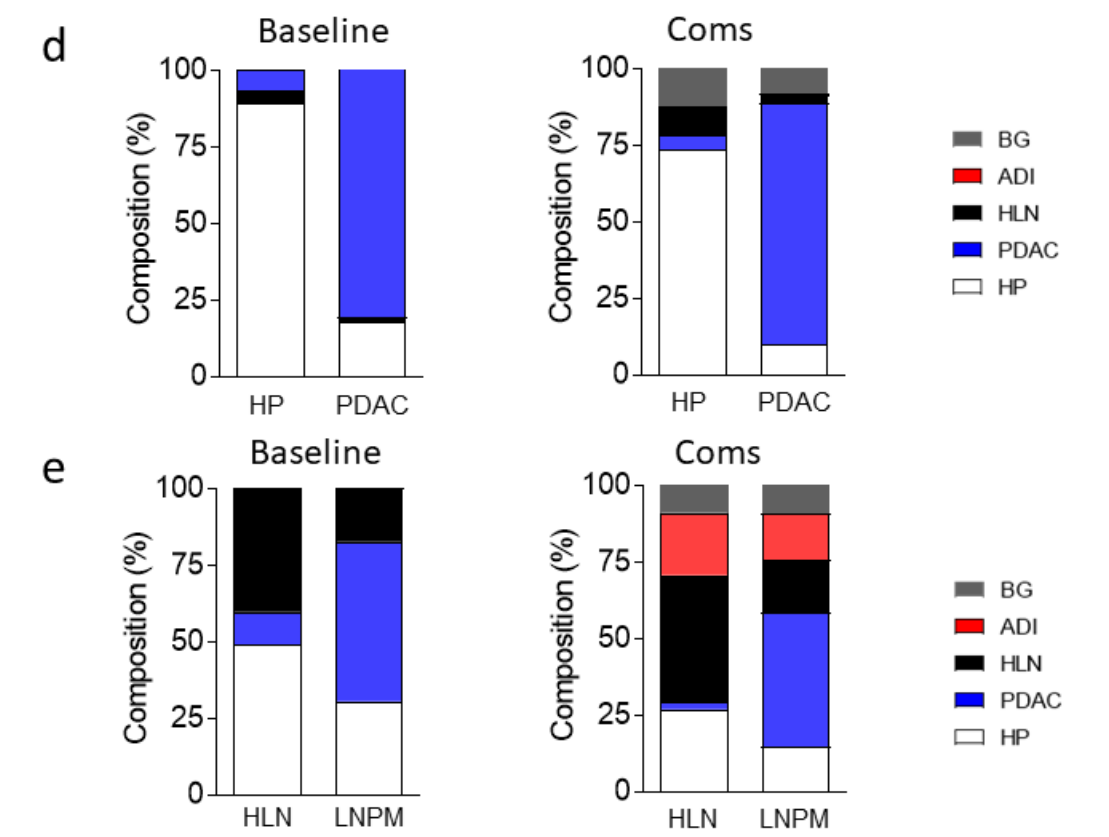
Figure 7. Communicator ‐ based clean ‐ up can be transferred to CNNs using a different input size. ( a ) Selection of the normalized 299 × 299 × 3 tissue patches based on the classification of the communicator CNNs using a 224 × 224 × 3 crop of the image tiles is illustrated (Spot: Scalebar = 300 μ m, Patch: Scalebar = 60 μ m). ( b ) Heatmap of the performance difference between the inceptionnetv3 trained on data with and without the data clean ‐ up via the communicators is shown. ( c ) Visualization of the classified validation data by the baseline or cleaned ‐ up inceptionv3 net. Healthy lymph node (HLN, yellow), healthy pancreas (HP, red), pancreatic ductal adenocarcinoma (PDAC, blue), background (BG, grey) and adipose tissue (ADI, cyan) classification is illustrated (scalebar = 2 mm). ( d ) Pooled classification, as determined using a baseline and cleaned inceptionv3 network from healthy pancreas (HP) ( n = 3) and pancreatic ductal adenocarcinoma (PDAC) images ( n = 15), is illustrated. ( e ) Average of classification, as determined using a baseline and cleaned inceptionv3 network of images showing healthy lymph nodes (HLN) ( n = 5) and lymph nodes with pancreatic ductal adenocarcinoma metastasis (LNPM) ( n = 6), is presented (ADI= adipose tissue, BG = background).